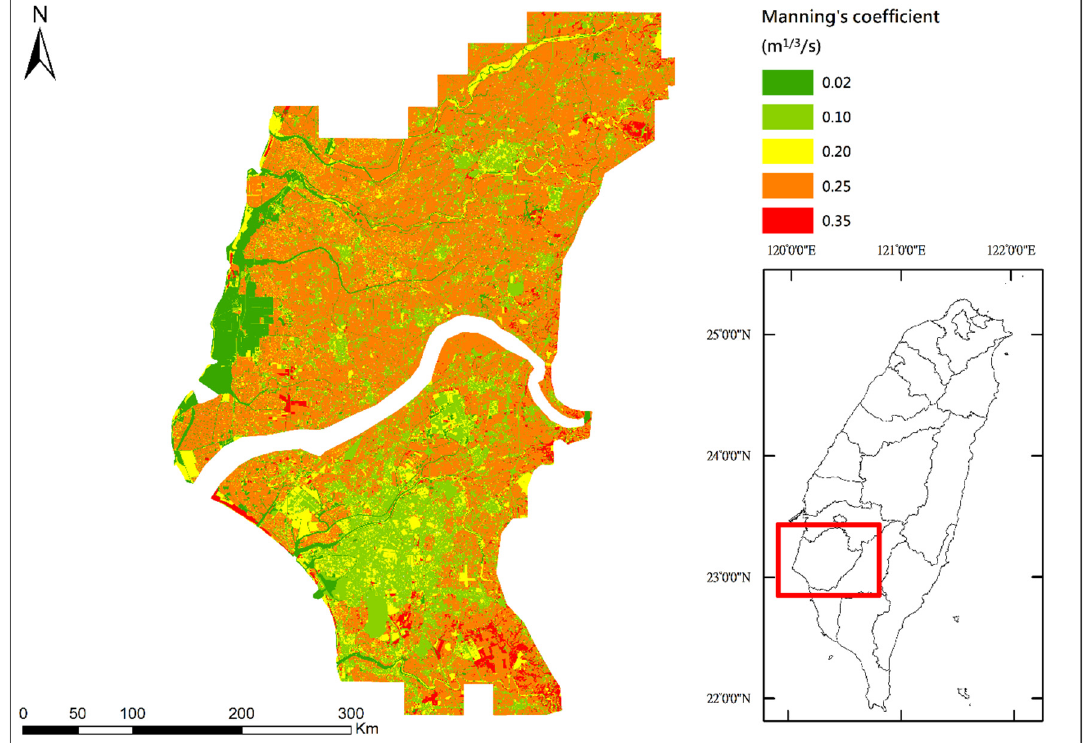
Figure 8. Spatial distribution of Manning’s coefficient corresponding to land use for the computational domain.